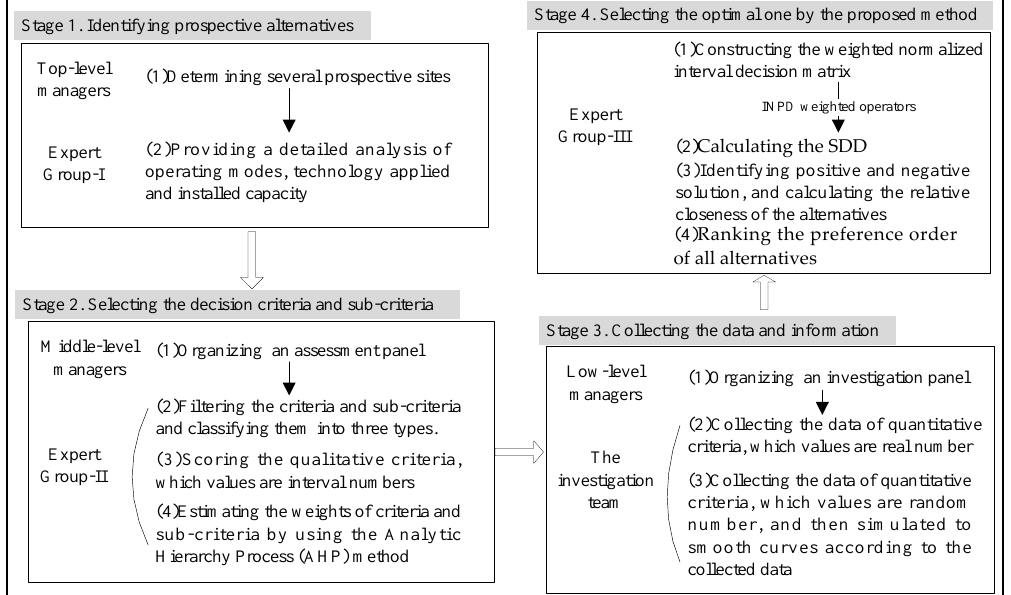
Figure 1. Decision framework of the international TPP site selection.